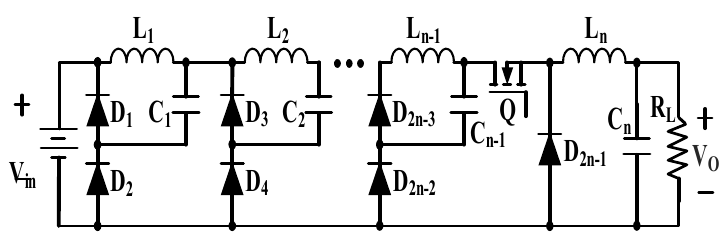
Figure 12. N-stage cascade buck converter.